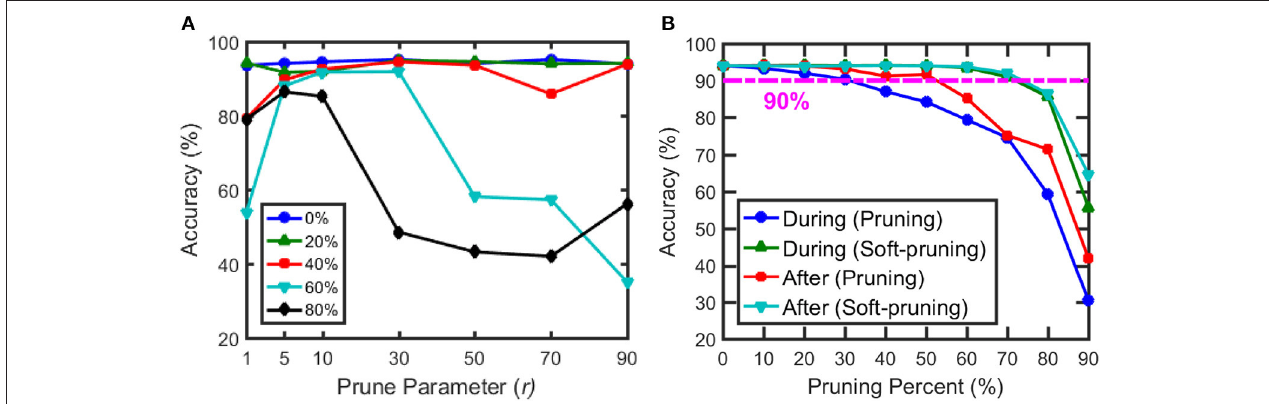
FIGURE 9 | (A) Classification accuracy vs. prune parameter ( r ) for varying pruning percentages. Prune parameter is the criterion to decide when to prune for each neuron during training. (B) Classification accuracy vs. pruning percentage for pruning and soft-pruning when applied during training and after training. The data points are taken in steps of 10%. The dashed line represents classification accuracy of 90%. Soft-pruning during the training performs better than pruning especially for high pruning percentages. Soft-pruning maintains > 90% up to 75% pruning percentage while pruning falls below 90% at only 40% pruning. Although we focus on pruning during training, we also present results from pruning weights after training as a baseline for previously established pruning methods from the literature. The parameters used in the simulation are specified in Table 1 .